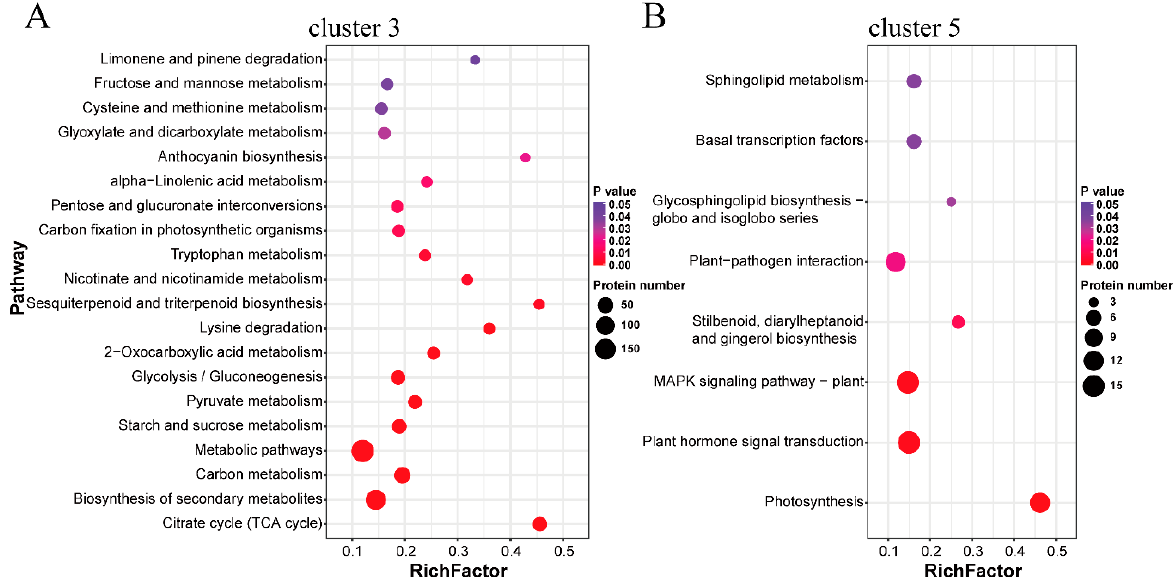
Figure 3. Kyoto encyclopedia of genes and genomes (KEGG) pathway enrichment analysis and Eukaryotic orthologous groups (KOG) annotation: ( A , B ) The main enriched KEGG pathways of cluster 3 and 5. The x-axis indicates the enrichment factor (RichFactor) which represents the number of DAPs annotated to each pathway divided by the number of all identified proteins annotated to the same pathway. A greater RichFactor indicates greater enrichment. The y-axis represents significantly enriched pathways with increasing significance from top to bottom.